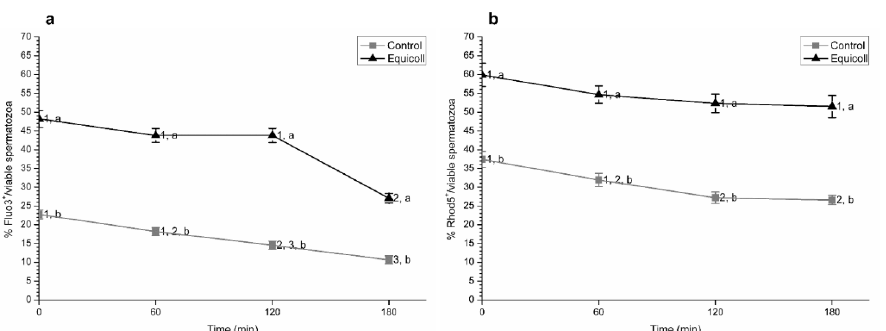
Figure 3. Proportions of viable spermatozoa with high intracellular calcium levels evaluated with two separate fluorochromes: Fluo3 ( a ) and Rhod5 ( b ) in control (non-selected samples) and SLC-selected samples (Equicoll). Data are given considering the viable sperm population. Different superscript letters (a, b) indicate significant differences ( p ≤ 0.05) between treatments within a given time point, and different superscript numbers (1–3) indicate significant differences between time points within the control or samples selected with Equicoll. Results are shown as mean ± SEM for 10 separate experiments. SLC: single layer centrifugation.